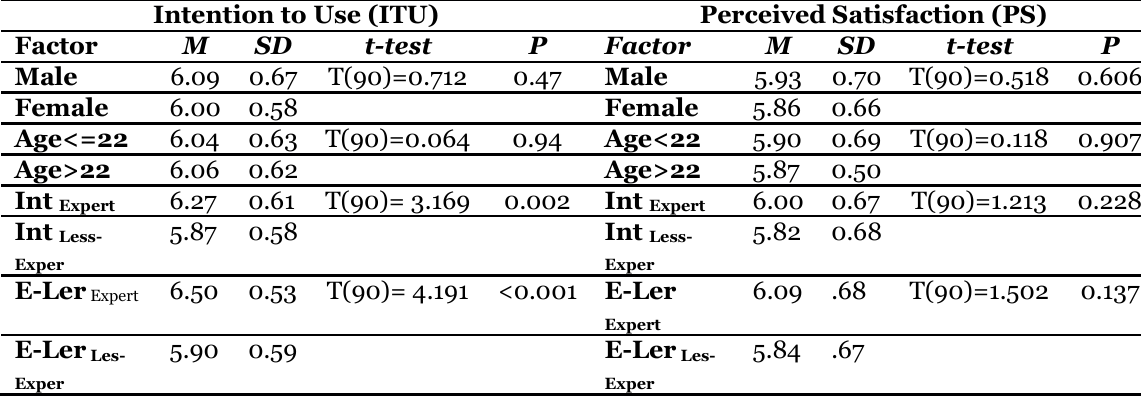
Findings of Independent Samples T-Test Intention to Use (ITU)